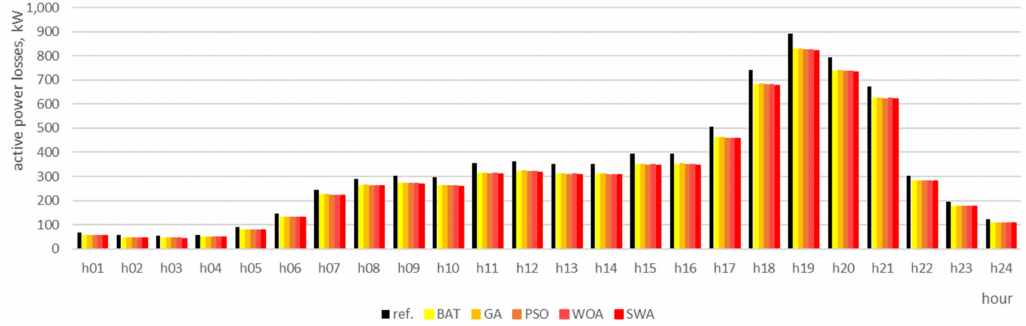
Figure 24. Hourly active power losses in the IEEE 33-bus system, for each algorithm. Table 14. Hourly and total power loss reduction in the 215-bus network, in %, for each algorithm.